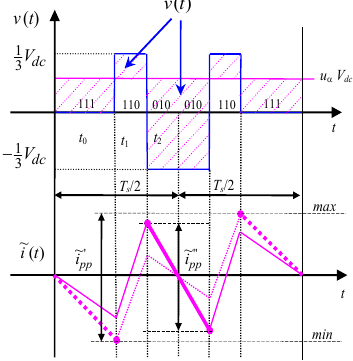
Figure 11. Output voltage and current ripple for DPWM+ technique in one switching period (sector II, 0 ≤ u α ≤ 1/3).